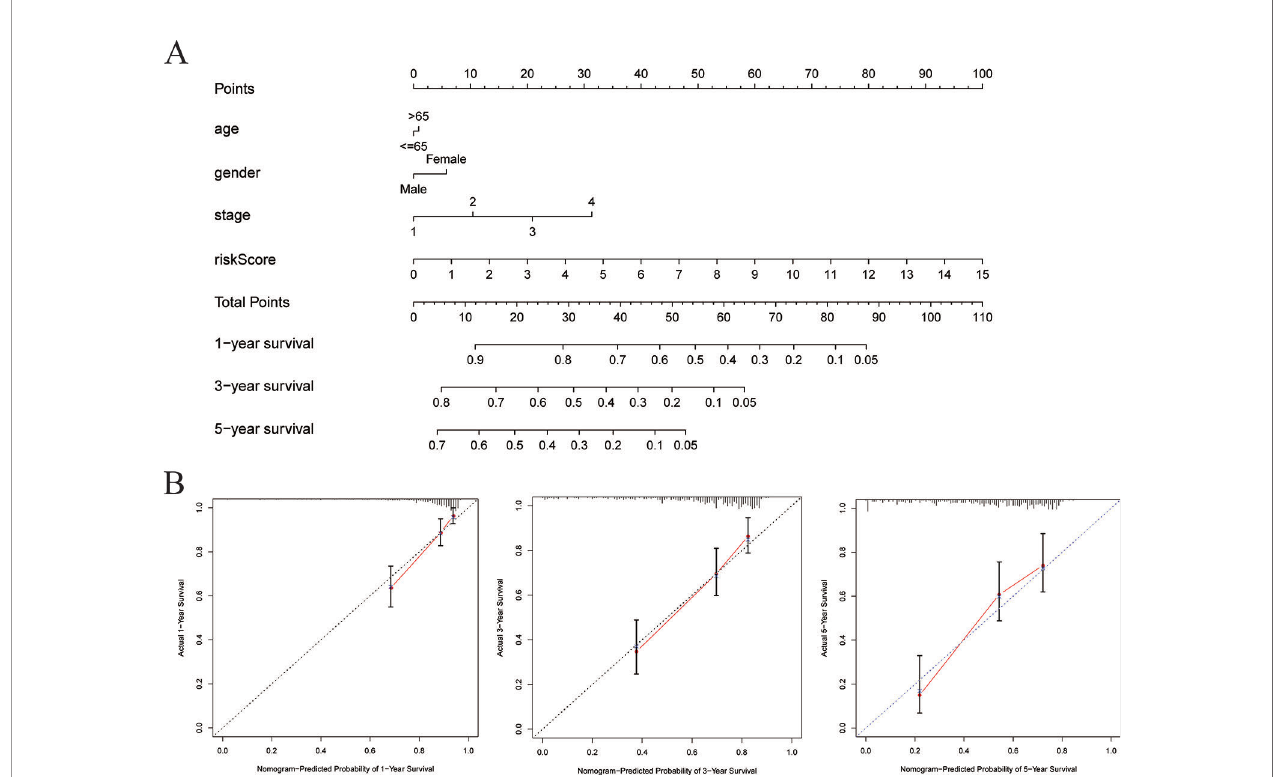
FIGURE 8 | Construction of a nomogram for survival prediction. (A) Nomogram combining signature with clinicopathological features. (B) Calibration plot showing that nomogram-predicted survival probabilities corresponded closely to the actual observed